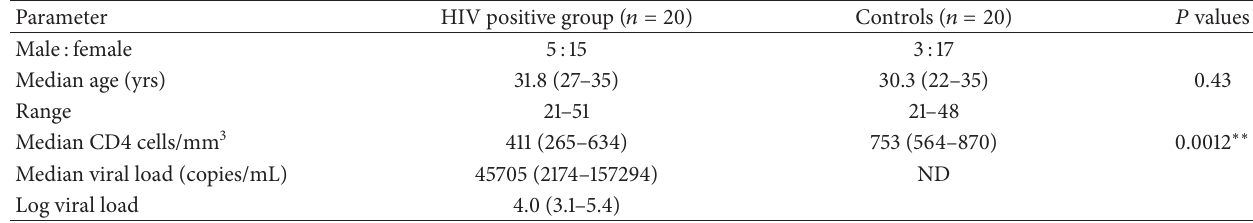
Table 1: Demographics characteristics of both the HIV positive and control